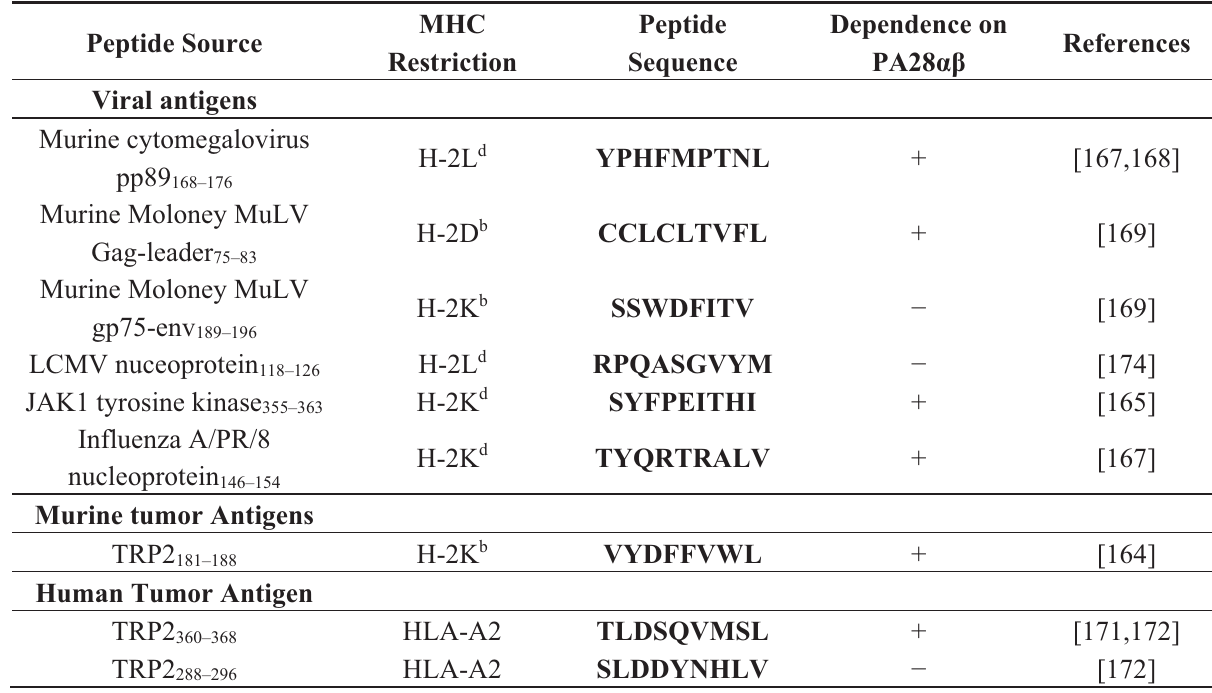
Table 2. The effect on the proteasome regulator PA28(cid:2)(cid:4) on the processing of viral and tumor antigens. LCMV, lymphocytic choriomeningitis